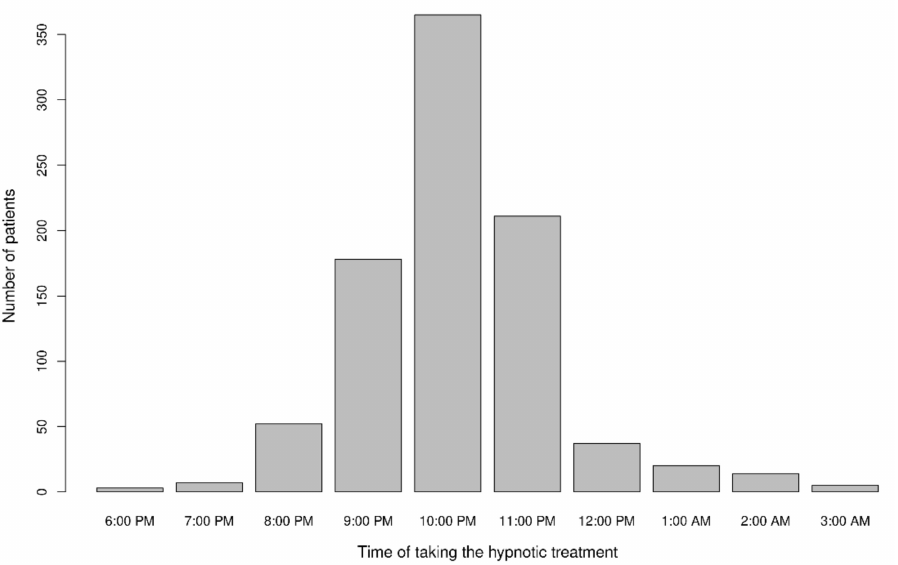
Figure 2. Time at which the hypnotic medication was taken (five patients took the hypnotic medica- tion at different times in the evening/night). Data were missing for 63 of the 960